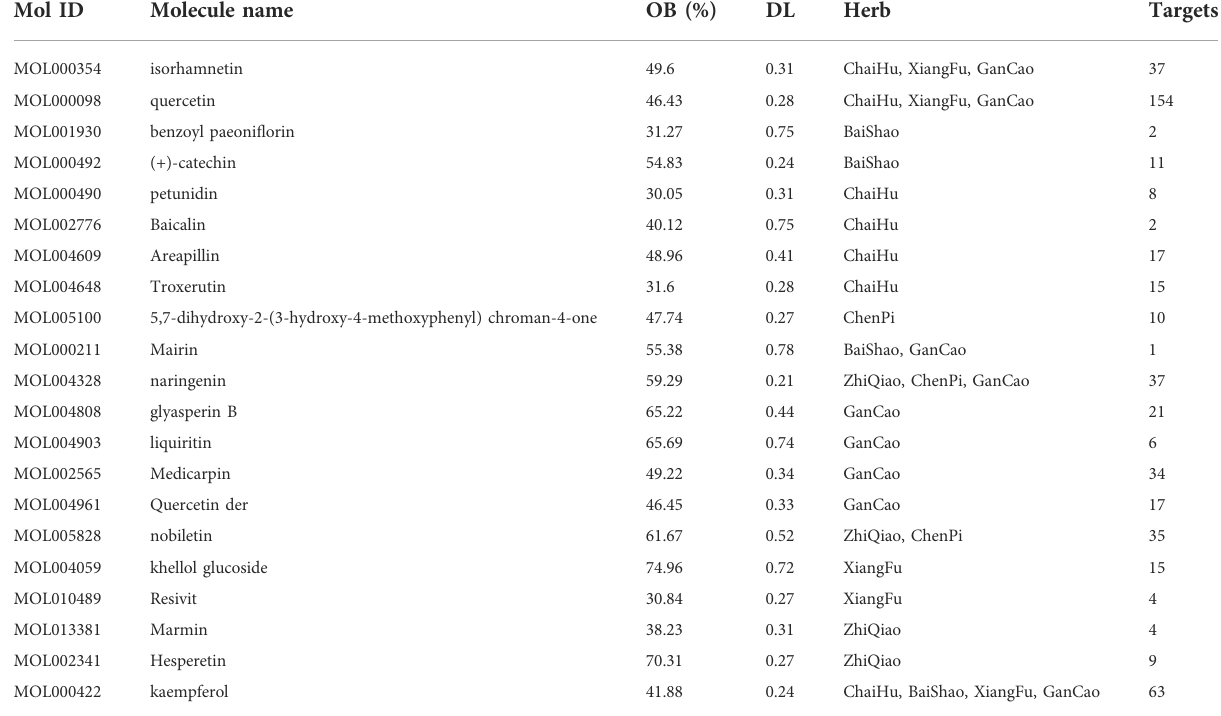
TABLE 1 The main compounds in CSP (OB ≥ 30% and DL ≥